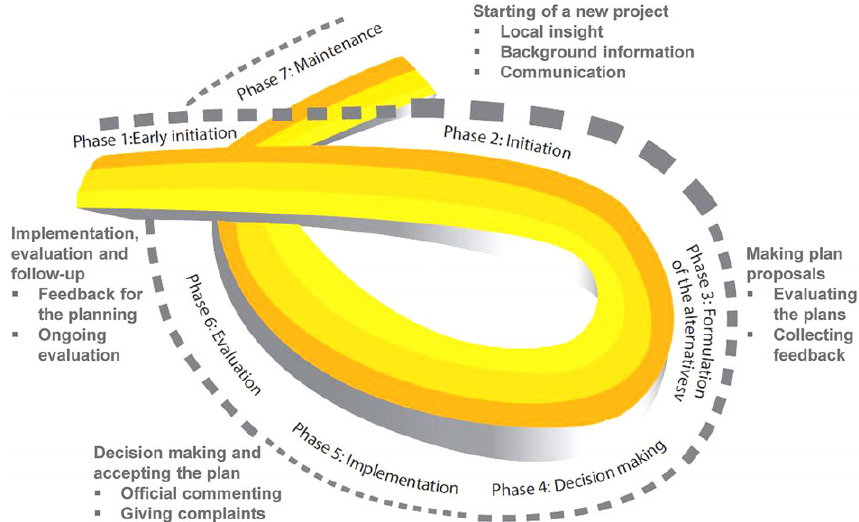
Fig. 1. Public participation support system by Kahila-Tani